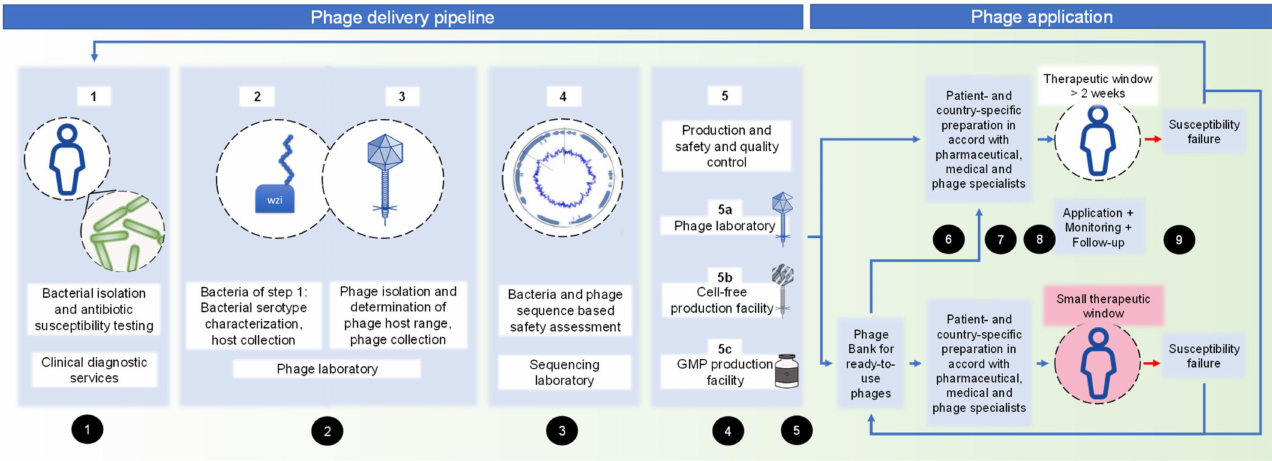
Figure 1. Pipeline of personalized phage delivery from an organizational perspective, considering different competencies and production sites. Numbers in black circles refer to the non-binding guidelines, Section 3.5 of this